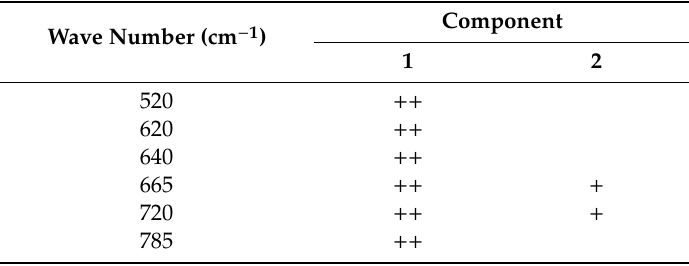
Table 5. PC coe ffi cients for the relevant FT-Raman microscopy spectral data from PC1 and PC2. A greater di ff erence from 0 indicates a greater contribution of that peak to the PCA separation for Caco-2 cells treated with oxidized